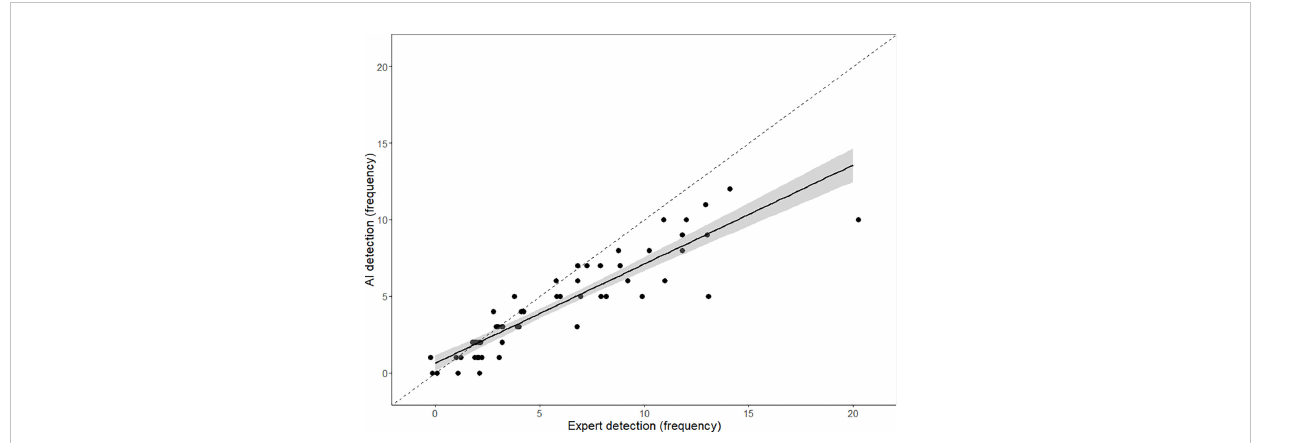
FIGURE 6 Expert and AI detection frequencies per frame. Linear regression and 95% CI. Dotted line shows perfect agreement. Note points “ jittered ” (by x = ± 0.2) to visualize the number of individual observations (n =